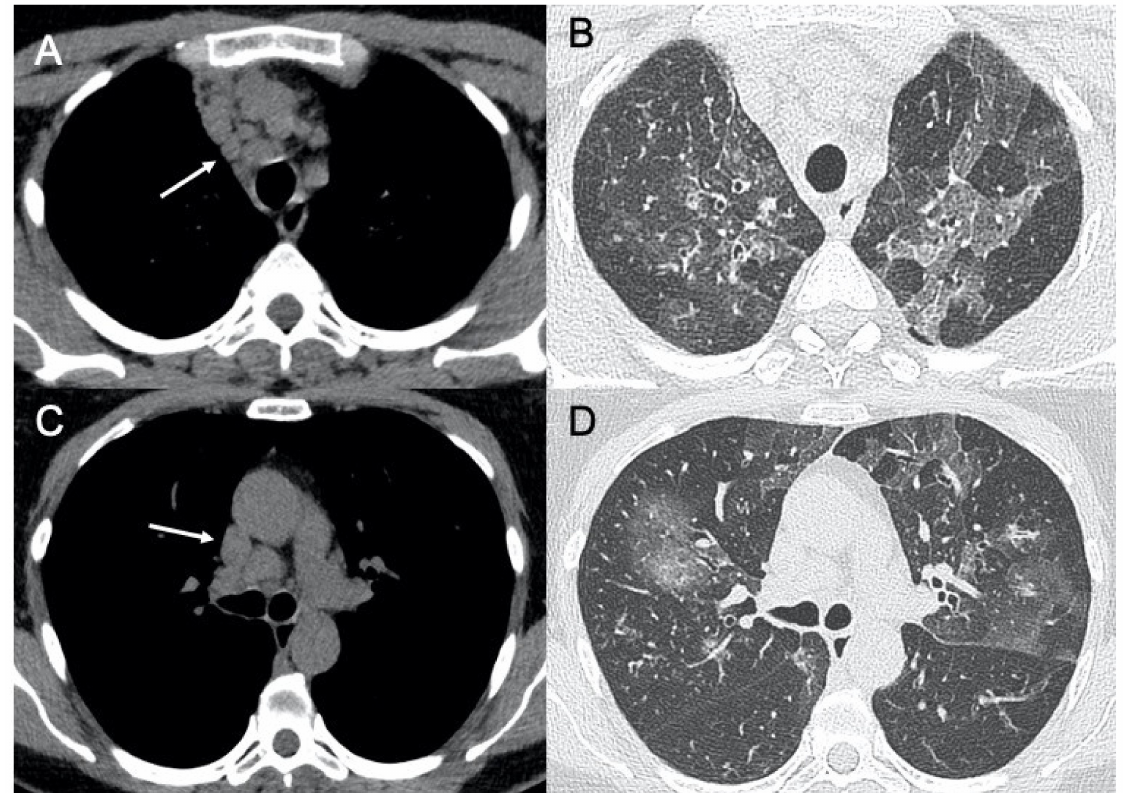
Figure 9. Epstein–Barr virus (EBV) pneumonia. A case of EBV pneumonia showing mediastinal lymphadenopathies (arrows in ( A , C )) associated with focal, lobular ground-glass opacities in both lungs ( B , D